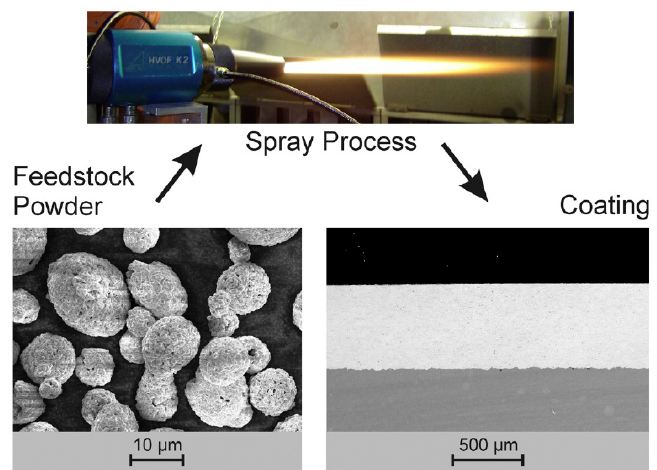
Figure 6. Schematic diagram of thermal spraying [45]. Reprinted with permission from [45]; 2014 Elsevier.